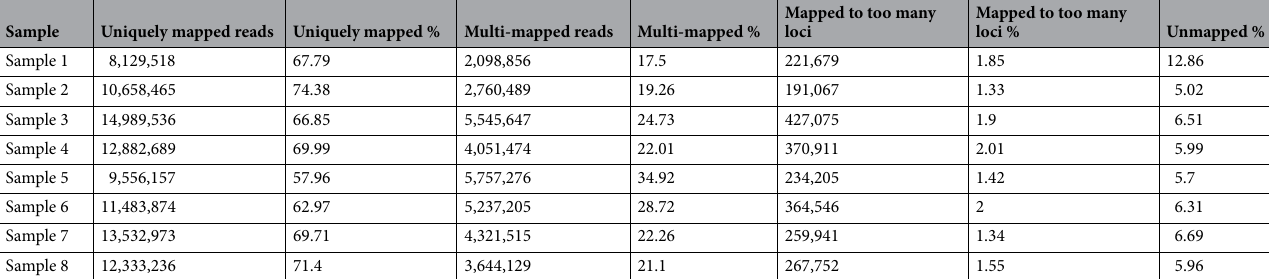
Table 3. Read alignment statistics for mouse RNA samples.